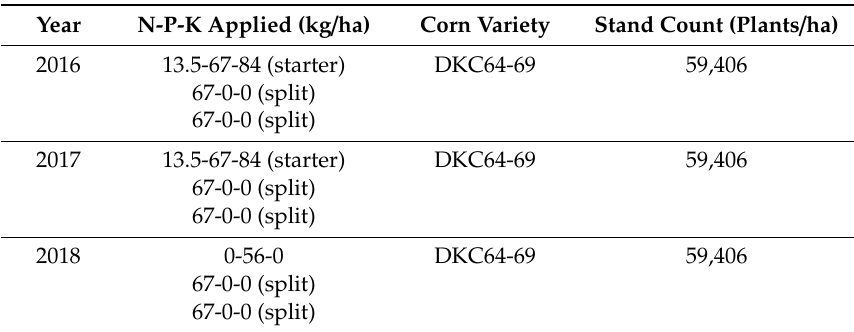
Table 3. Agronomic management of